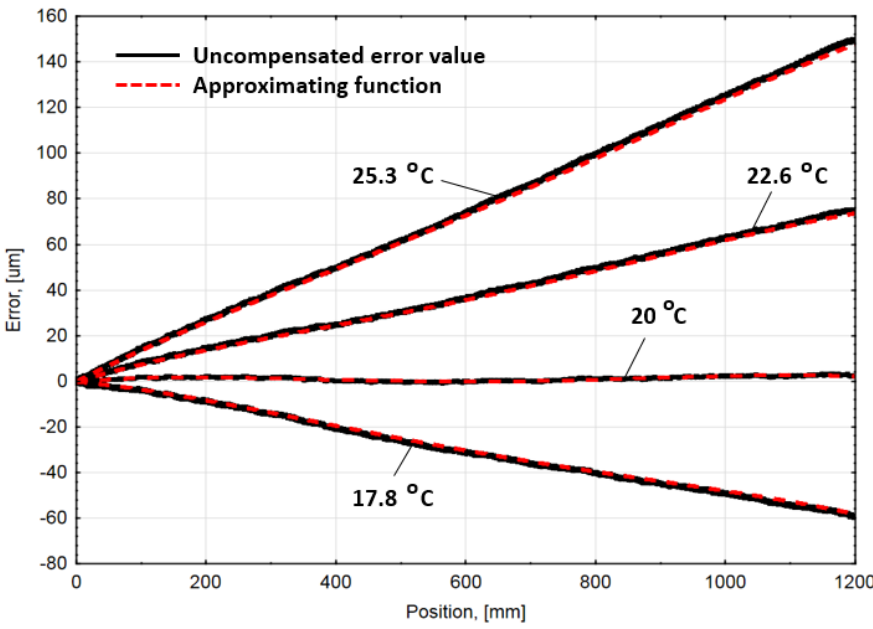
9 of 16 Figure 6. Average accuracy graph of compensated tested encoder at 20 °C ambient temperature. In order to minimize encoder error at different ambient temperatures, the third com- ponent of the general error Equation (4) must be found. The mechanical construction and the thermal behavior of the linear encoder were investigated in a previous work [43] by using the finite element method (FEM). The computer simulation showed that the linear thermal expansion coefficient (CTE) of the measuring scale was greatly changed because of its fixing type, mass, and geometry differences between the scale and the extrusion, etc. Due to these reasons, the CTE of the scale was increased up to α (cid:2913)(cid:2925)(cid:2928)(cid:2928)(cid:2915)(cid:2913)(cid:2930)(cid:2915)(cid:2914) = 22.9 μ m/ (cid:4666) m (cid:2925) C (cid:4667) . This value was used for the third member calculation, according the Equation (6). The ambient temperature difference from the nominal temperature was calculated according to the mean value of several external temperature sensor readings. The mathematical al-